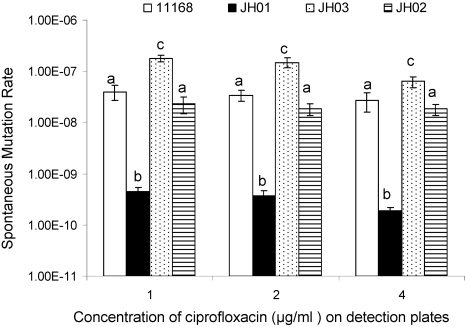
Frequencies of emergence of spontaneous FQR mutants in different C. jejuni strains including the wild-type 11168, the mfd mutant (JH01), the complemented mfd mutant (JH02), and the mfd-overexpressing construct (JH03).Three different concentrations of CIPRO (1, 2, and 4 µg/ml, respectively) were used in the detection plates to count FQR colonies. Each bar represents the mean±standard deviation of frequencies from three independent cultures. The bars labeled with different letters indicate that they are significantly different (P<0.05).